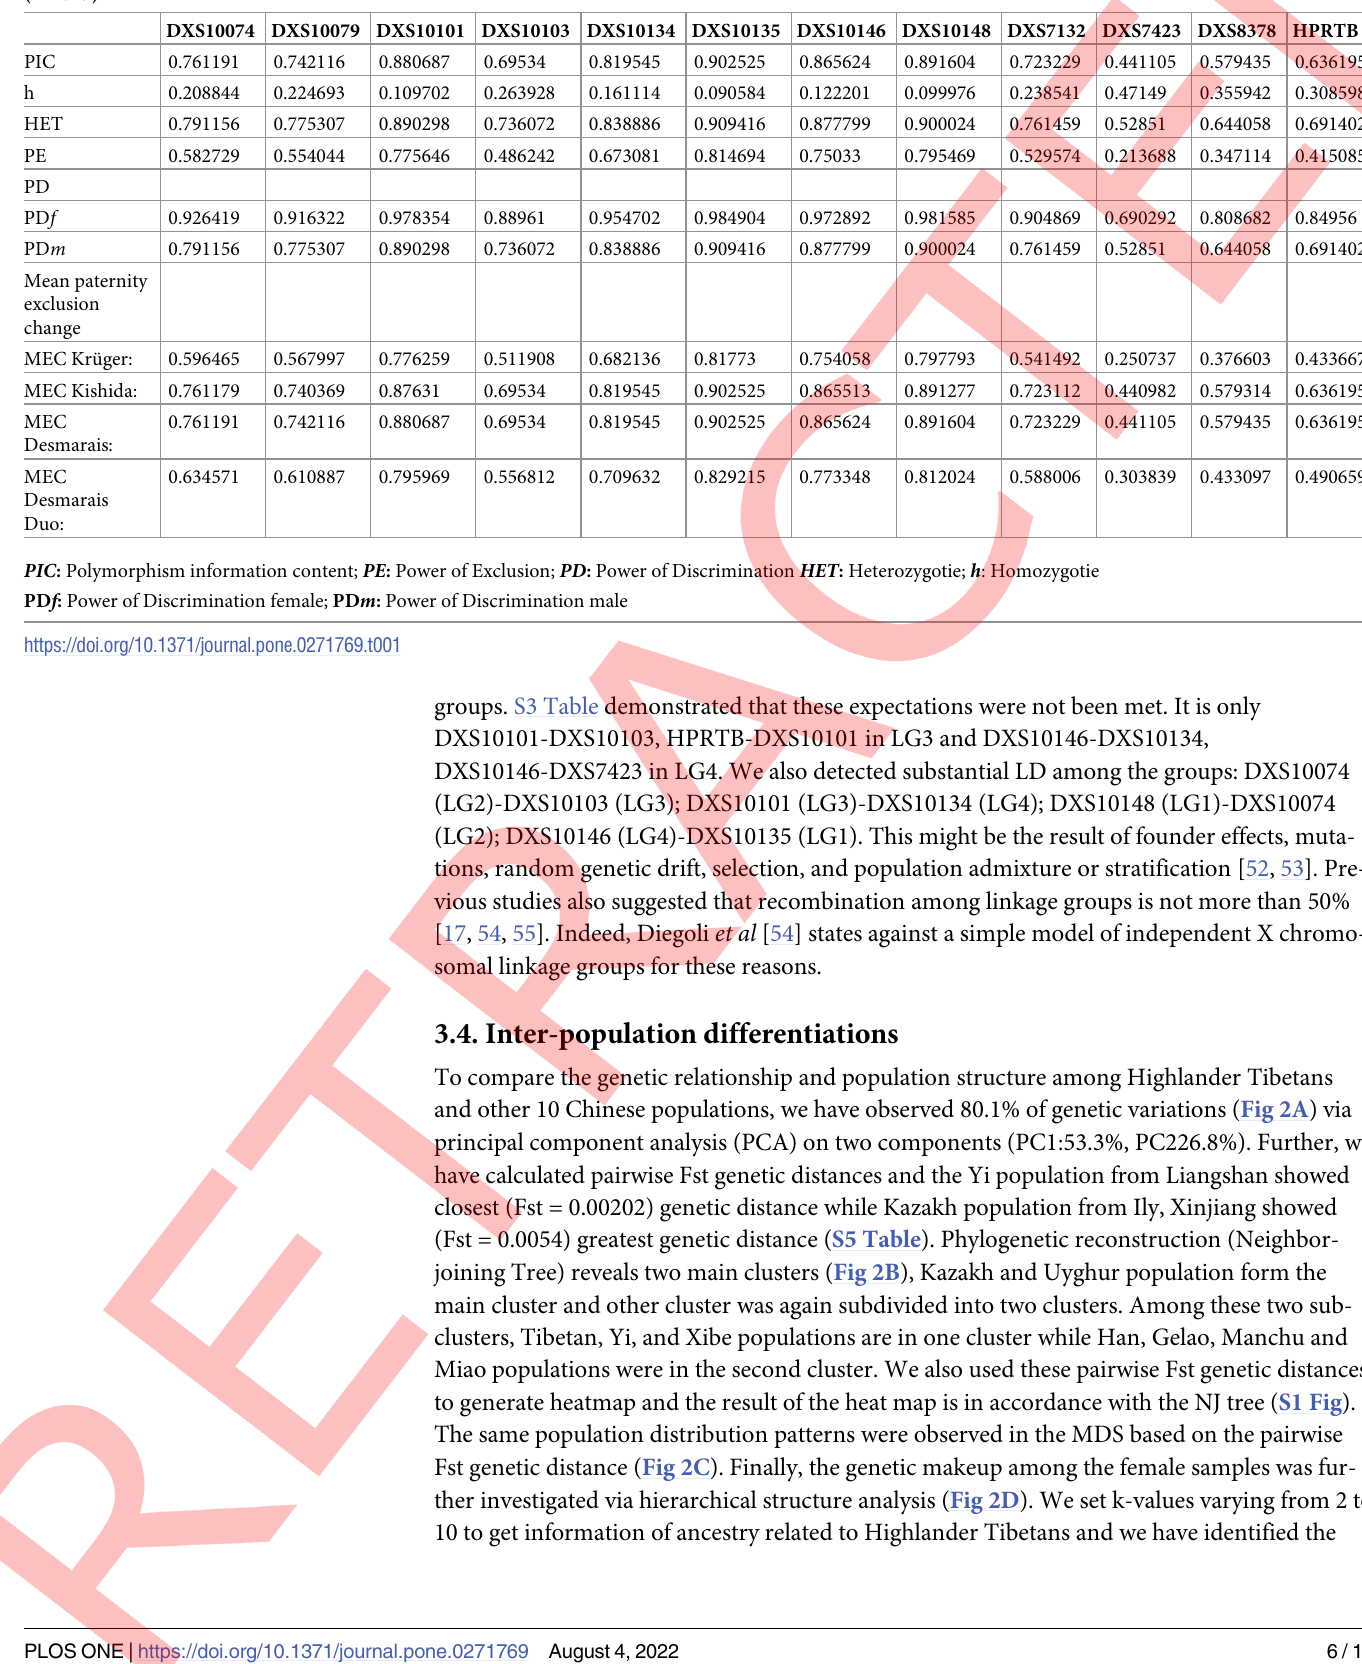
Table 1. Forensic parameters of the 12 X-STR loci in Tibetans population residing in Nagqu city in the north of the Tibet Autonomous Region (TAR) in China (n =